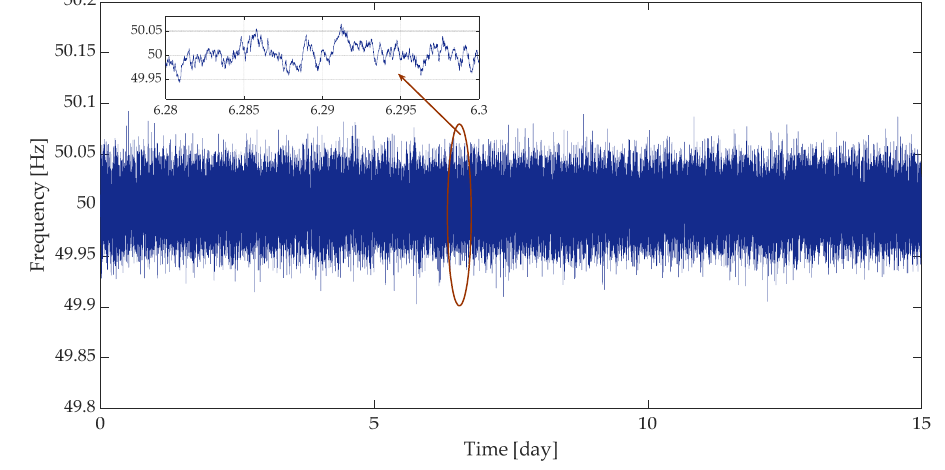
Figure 12. Frequency data estimated according to the Ornstein–Uhlenbeck process.